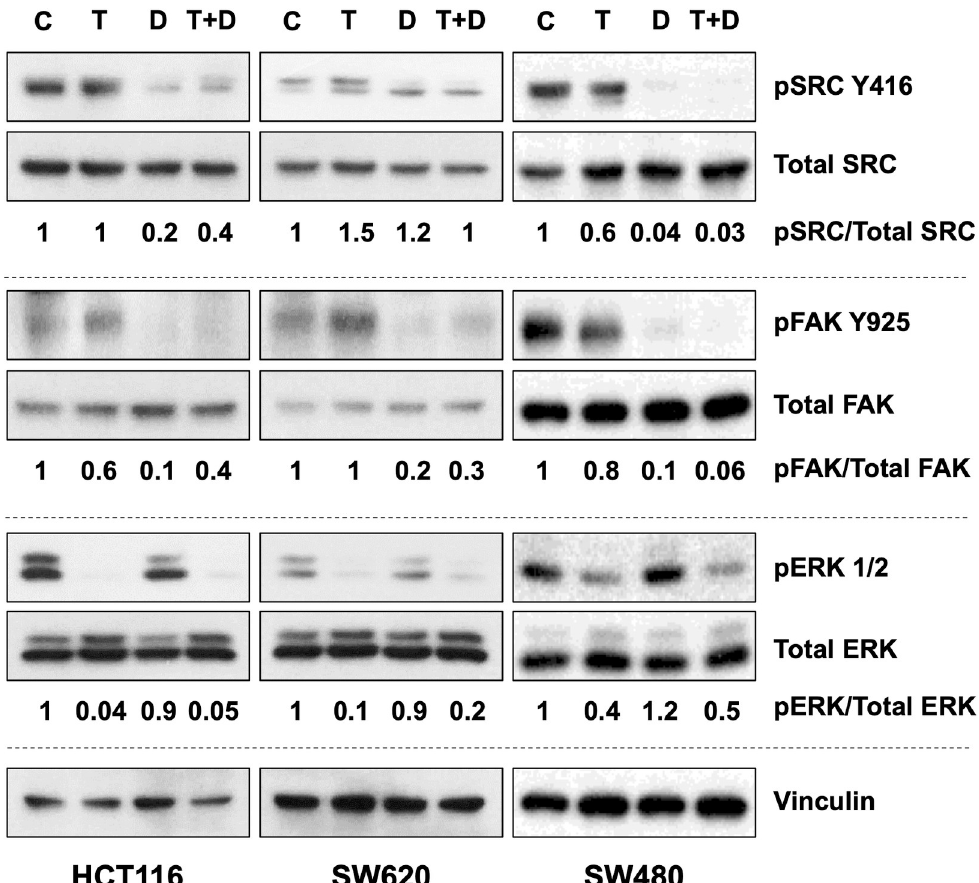
Fig 3. Combined targeting of SRC and MEK inhibits compensatory survival signaling pathways in multiple KRAS- mutated CRC cell lines treated with MEK inhibitors alone. Western blots performed to detect changes in the levels of the signaling factors pSRC, pFAK, and pERK in multiple KRAS-mutated CRC cell lines are shown. Changes in phosphorylation levels were compared with their respective total levels. Vinculin was used as a loading control. C, control; T, trametinib; D, dasatinib; T+D, trametinib and dasatinib. The numbers below the blots denote the phospho-protein levels relative to total protein levels in each sample (Control cells standardized to 1).